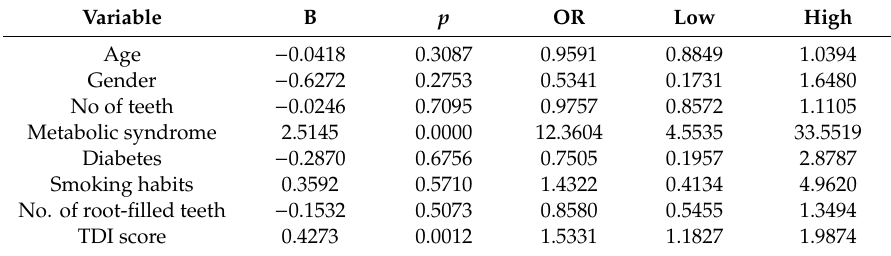
Table 4. Multivariate logistic regression analysis of the influence of the independent variables age, gender (0 = women, 1 = male), number of teeth, metabolic syndrome (0 = absent, 1 = present), diabetes (0 = absent, 1 = present), smoking habits (0 = non-smoker, 1 = smoker), number of root-filled teeth, and TDI on the dependent variable “cardiovascular events” (0 = absent, 1 = present). Variable B p OR Low High Age − 0.0418 0.3087 0.9591 Gender − 0.6272 Metabolic syndrome 2.5145 Diabetes −